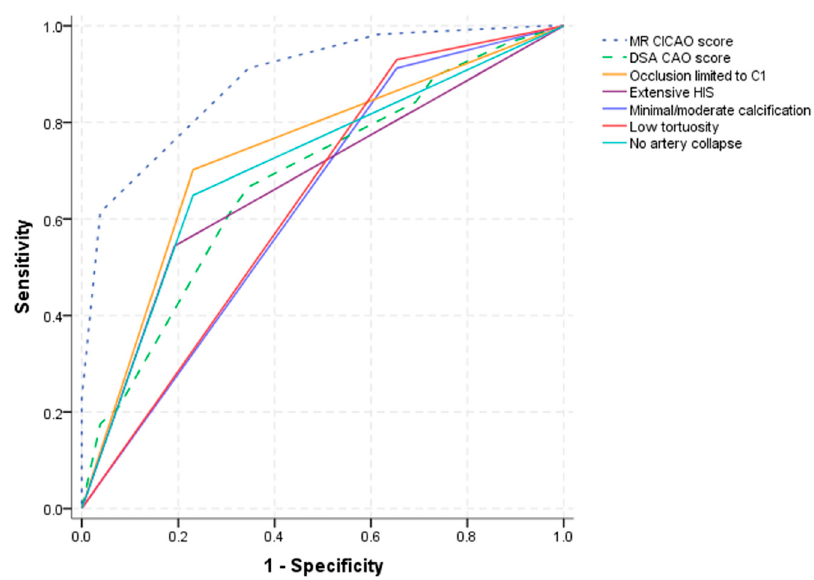
Figure 2. Receiver-operating characteristic (ROC) curves of the MR CICAO score, the DSA CAO score and each single MR-VWI characteristic used to predict successful endovascular recanalization. Area under curve (AUC) of the MR CICAO score = 0.888 (95%CI: 0.816–0.960; p < 0.001), cut-off value: 3.5, and AUC of the DSA CAO score = 0.682 (95%CI: 0.559–0.804; p = 0.008), cut-off value: 3.5. Table 3. Multivariate analysis of MR-VWI predictors of successful recanalization.